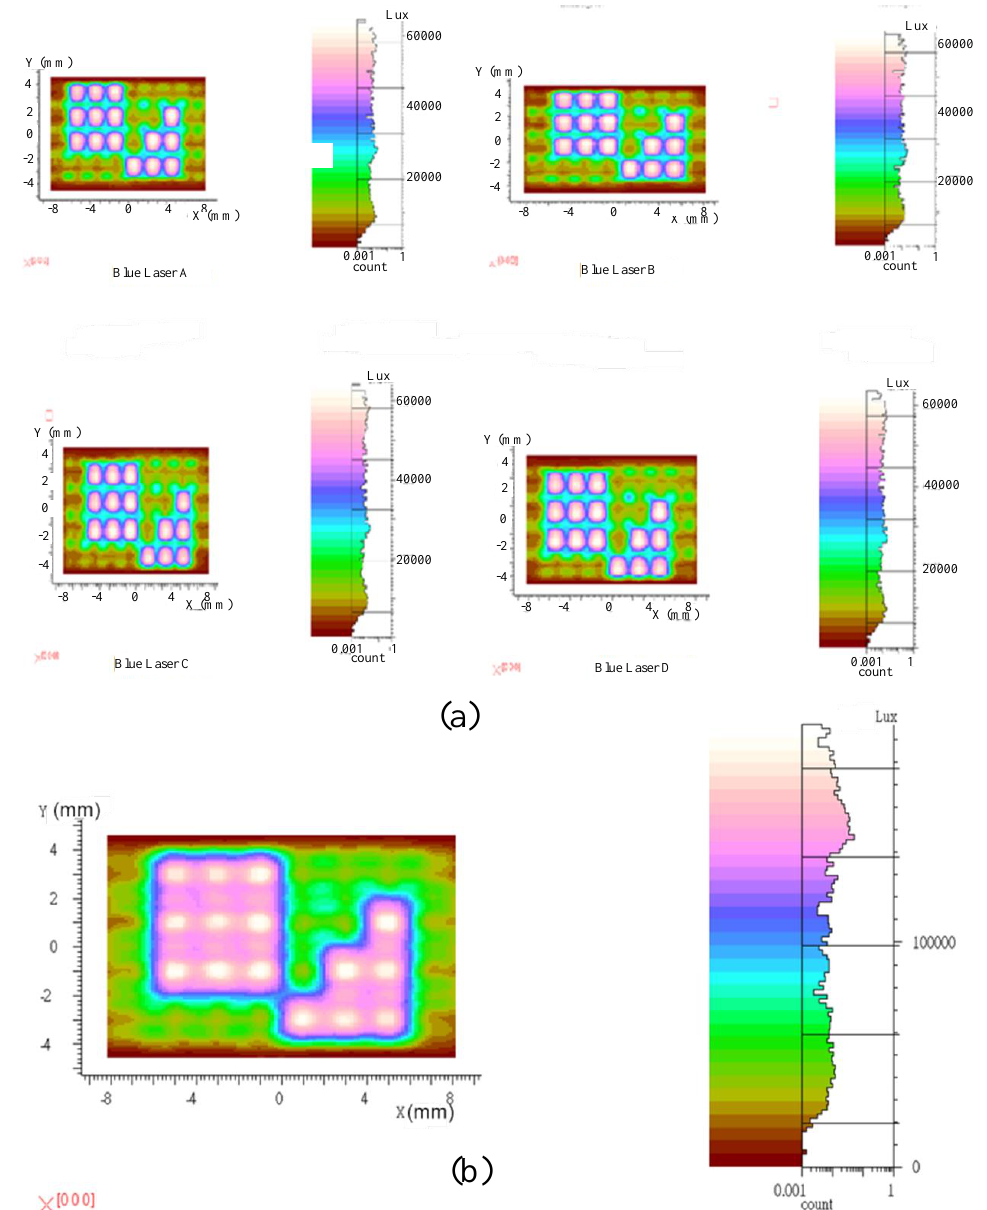
Figure 13. ( a ) Single blue laser, displaying displacement map for local dimming (liquid crystal lens with pore size of 2.0 mm and a focal length of 9 cm). ( b ) Four blue lasers, displaying compensation for light source micro scanning (liquid crystal lens with pore size of 2.0 mm and a focal length of 9 cm). Table 4. Contrast and light efficiency for a single red laser and cyclic micro-scanning laser (liquid crystal lens with pore size of 2.0 mm and a focal length of 9 cm). Brightness Laser A Laser B Laser C Laser D Cyclic Laser Brightest spot of the optical spot (unit: Lux) 508,182 508,257.375 1233,362.63 Darkest spot of the optical spot (unit: